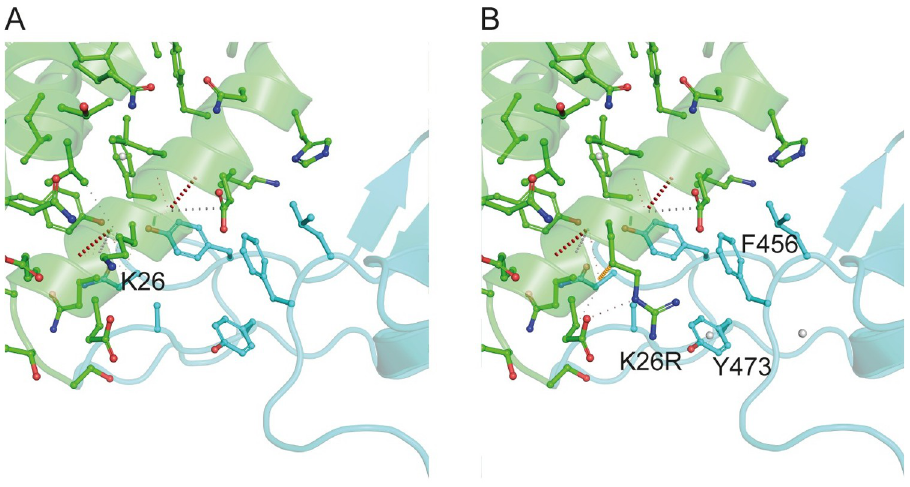
Fig 3. The structure of ACE2 (green) gnomAD [24] missense variant p.Lys26Arg that enhances Spike (light blue) binding affinity. A. The environment of ACE2 Lys26 from PDB ID: 6vw1 [11]. B. Model of ACE2 p.Lys26Arg in complex with Spike. The mutant structure was modelled onto 6vw1 with mCSM-PPI [13]. Figure created with PyMol [29].